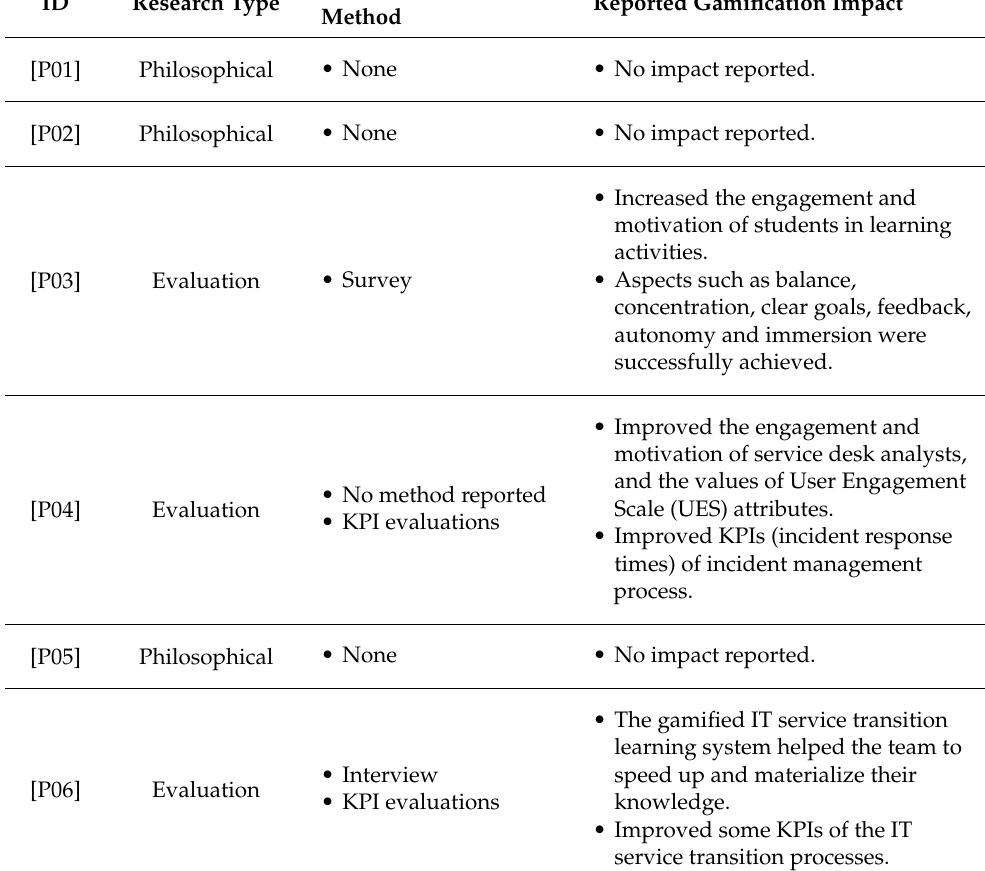
Table 15. Summary of the gamification impact reported in the primary